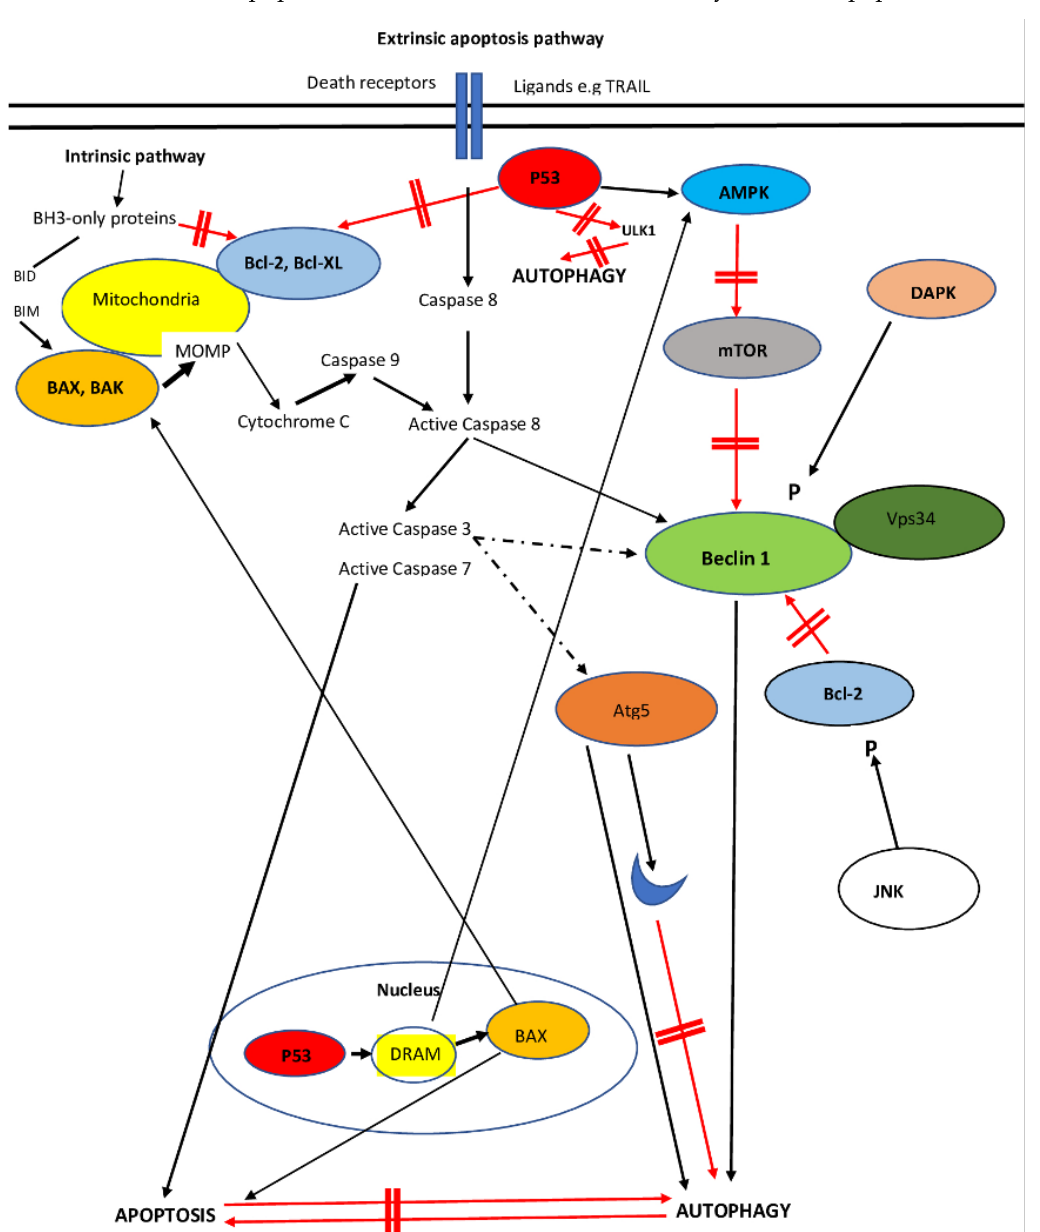
Figure 2. A simplified diagram of the interplay of autophagy and apoptosis. Most controllers of the interplay are presented. p53, the main gatekeeper, increases autophagy directly or indirectly through the DRAM activation of AMPK, but cytoplasmic p53 may inhibit autophagy. p53 increases apoptosis via the inhibition of Bcl-2 or the overexpression of BAX. Bcl-2, associated with Beclin1, inactivates the complex, leading to increased autophagy (only Vps34 is shown here). The phosphorylation of either Beclin1 by DAPK or Bcl-2 by JNK liberates the pro-autophagy complex. DAPK also increases apoptosis by an unknown mechanism. The cleavage of Beclin1 or Atg5 (an autophagy inducer promoted by ER stress) by apoptosis-induced caspases inhibits autophagy. Several inter- mediate components have been omitted for clarity. Intermittent line: Cleavage.